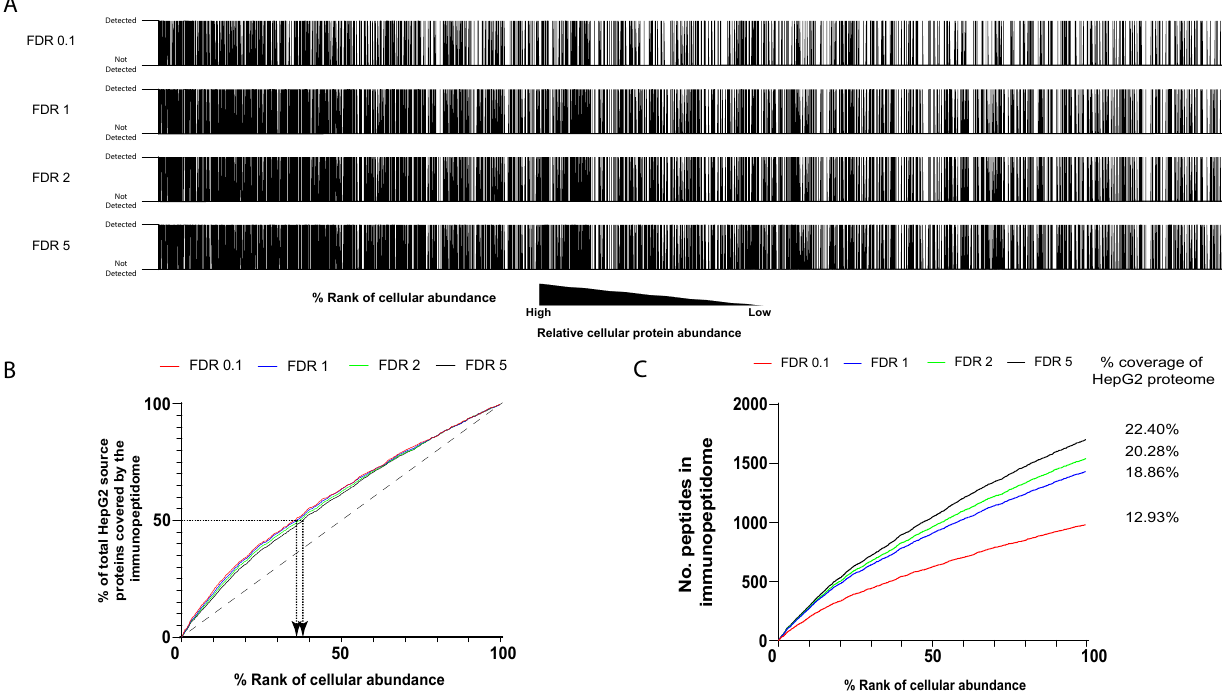
Figure 2. Comparison of our HepG2 immunopeptidome to the quantitative HepG2 cellular proteome: ( A ) proteins from the HepG2 proteome were sorted by cellular expression from high (left) to low (right). Then source proteins in this list for which one or more 9–11 mer peptides were identified in the HepG2 immunopeptidome, using indicated FDR cutoffs, were marked by a vertical line to yield barcodes. ( B ) While “walking” from left to right over these barcodes a cumulative score was calculated by adding a 1 for each protein hit in the immunopeptidome. At each position in the abundance ranked protein list ( x -axis) this cumulative score was then plotted as a percentage of the total of proteins covered by the immunopeptidome and also by the full HepG2 proteome ( y -axis). Arrows indicate the % of top ranking source proteins that produced 50% of HLA-peptides. ( C ) As in B but representing the cumulative absolute number of proteins covered by the immunopeptidome at each cellular abundance rank. Indicated on the right is the percentage of proteins in the HepG2 proteome from which peptides were identified in the